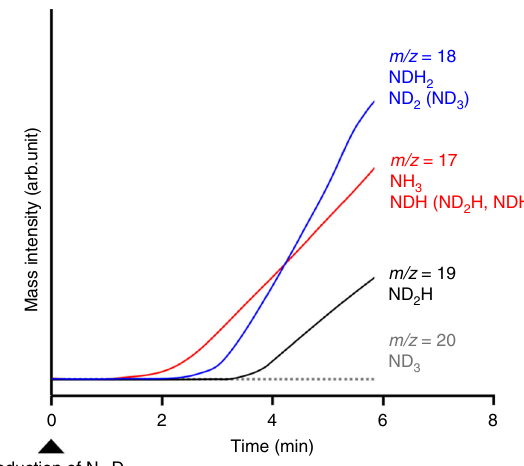
Fig. 4 Time courses of ammonia synthesis from N 2 and D 2 over